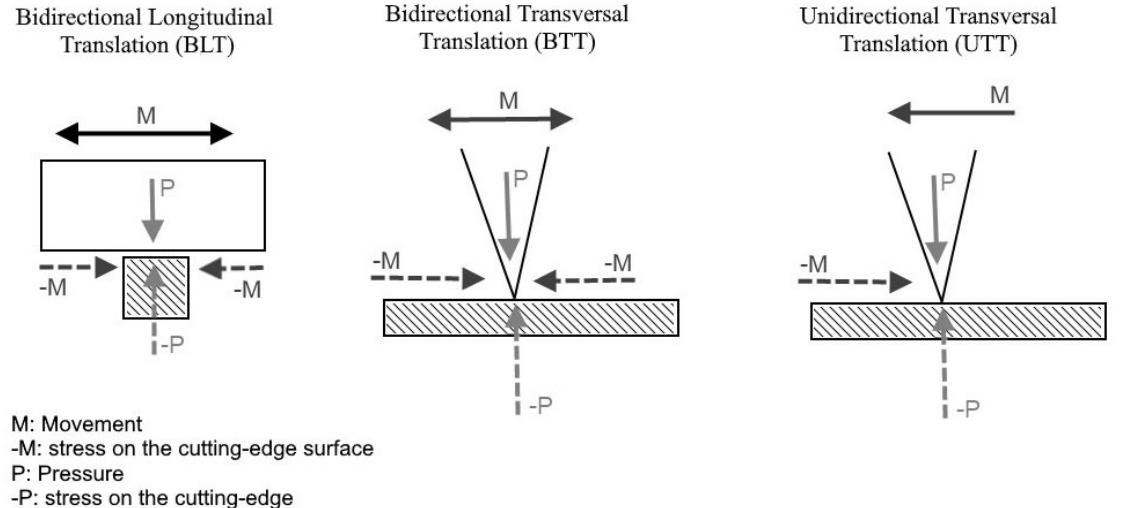
Figure 1. Schematic representation of the three types of motion tested